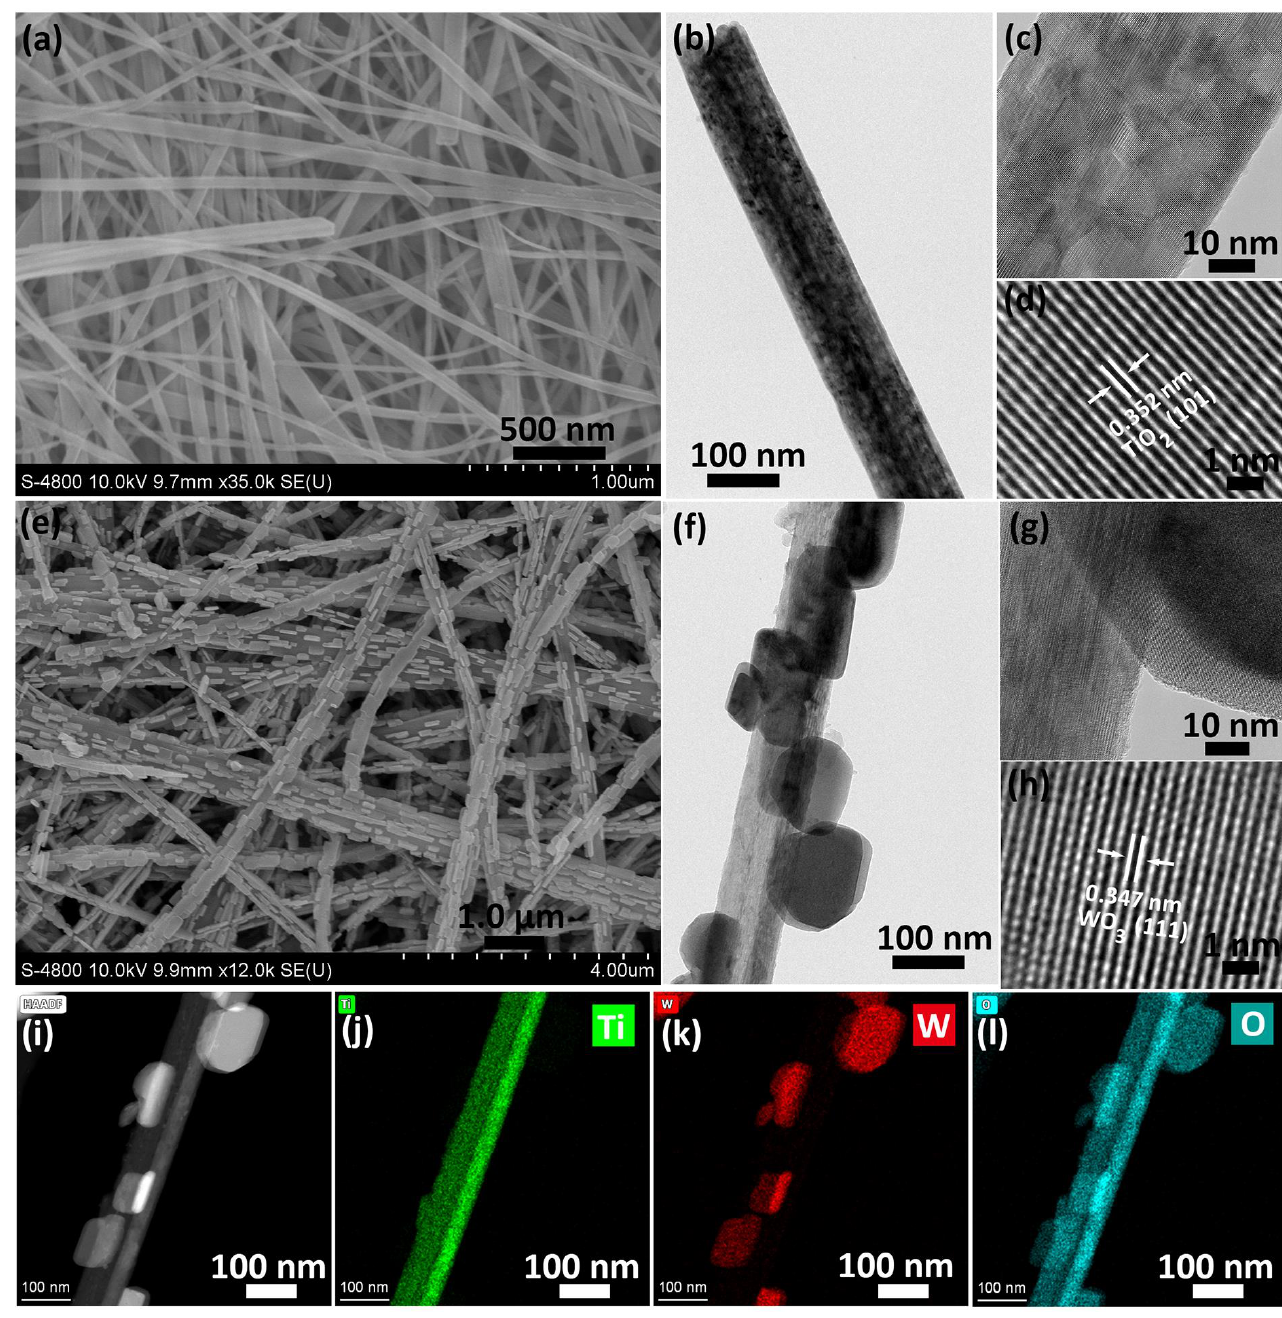
Figure 2. ( a ) SEM image of TiO 2 nanoribbons. ( b – d ) TEM images of TiO 2 nanoribbons. ( e ) SEM im- age of WO 3 /TiO 2 -25 heterostructure. ( f – h ) TEM images of WO 3 /TiO 2 -25 heterostructure. ( i – l